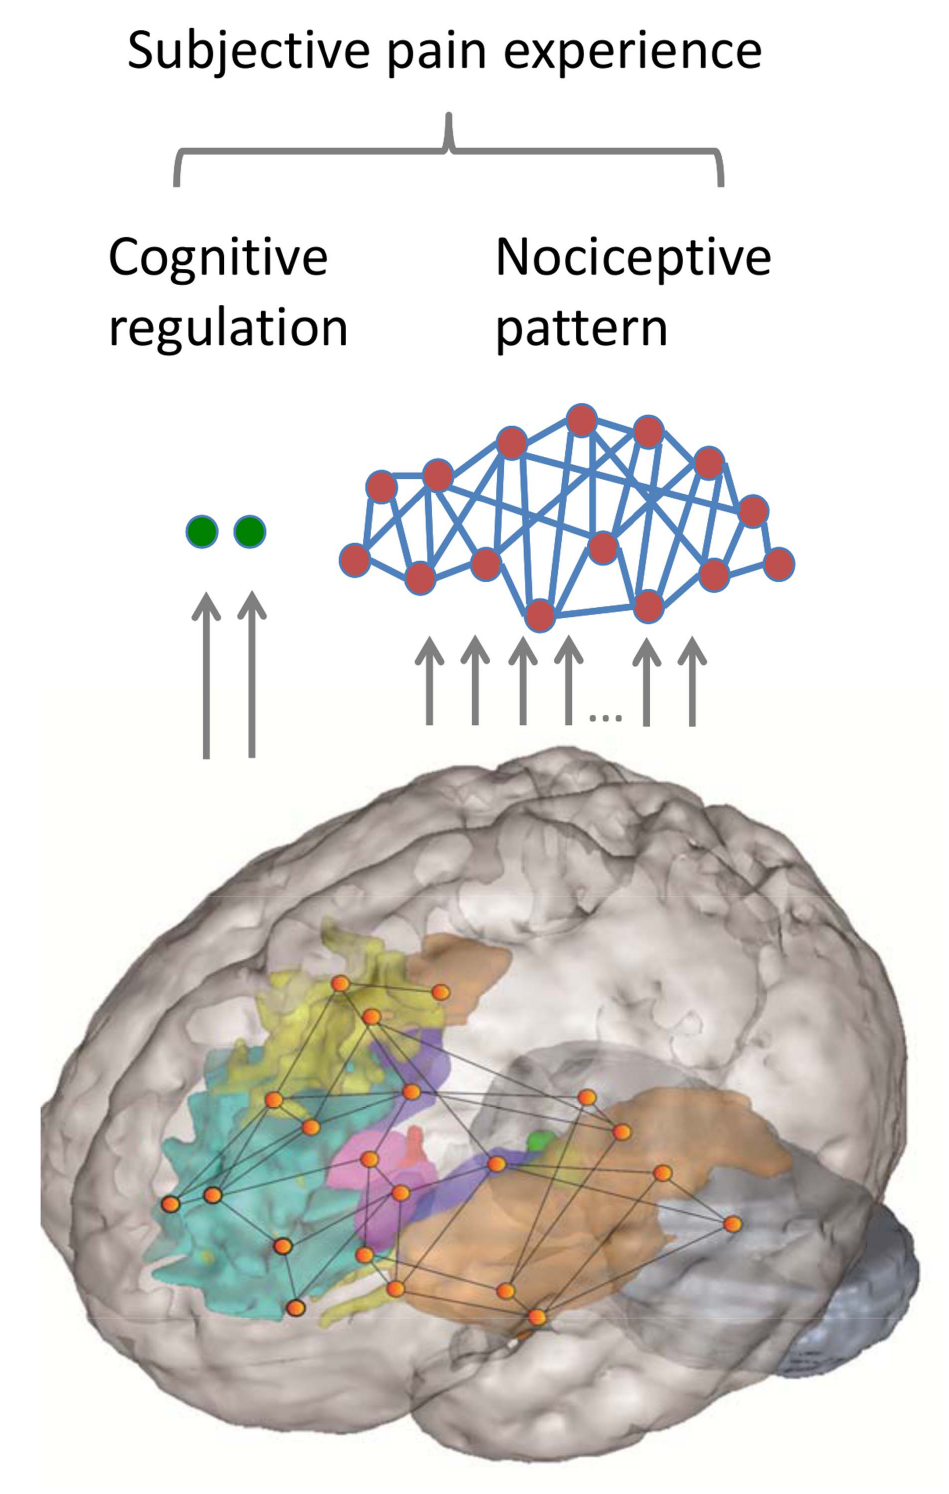
Fig 1. Distinct component to the subjective perception of pain. Core nociceptive nodes comprise a multivariate pattern (the neurological pain signature [NPS]), and fronto-striatal brain regions comprise an evaluative pathway sensitive to self-directed cognitive modulation.